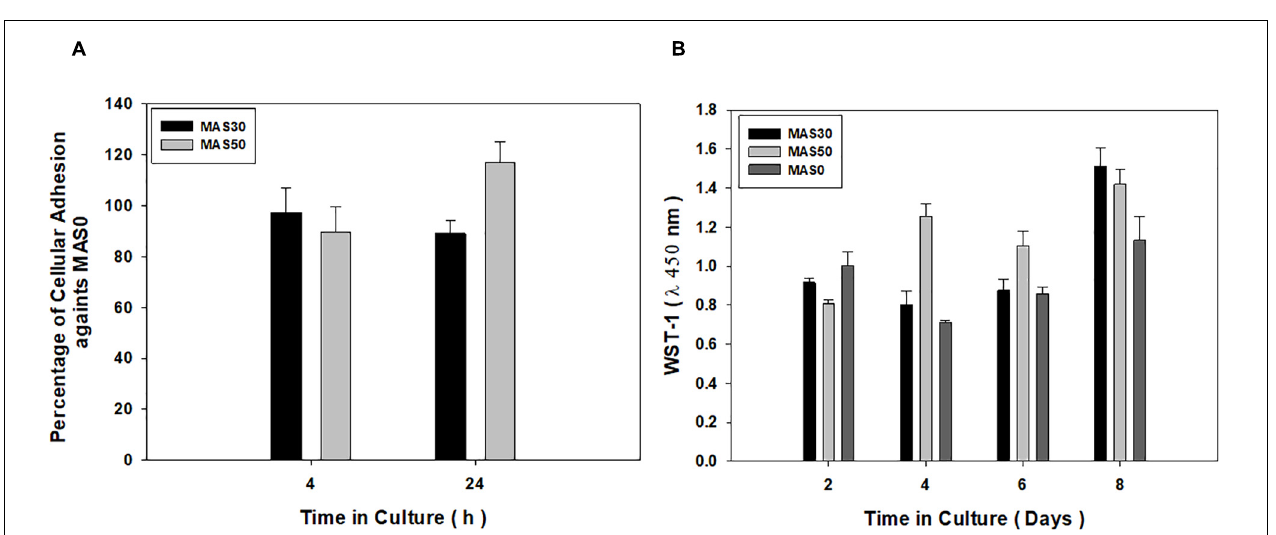
FIGURE 2 | In vitro biological response of hDP-MSC to MAS0, MAS30, and MAS50. (A) Cell adhesion at 4 and 24 h and (B) cell viability after 2, 4, 6, and 8 days of cell culture.